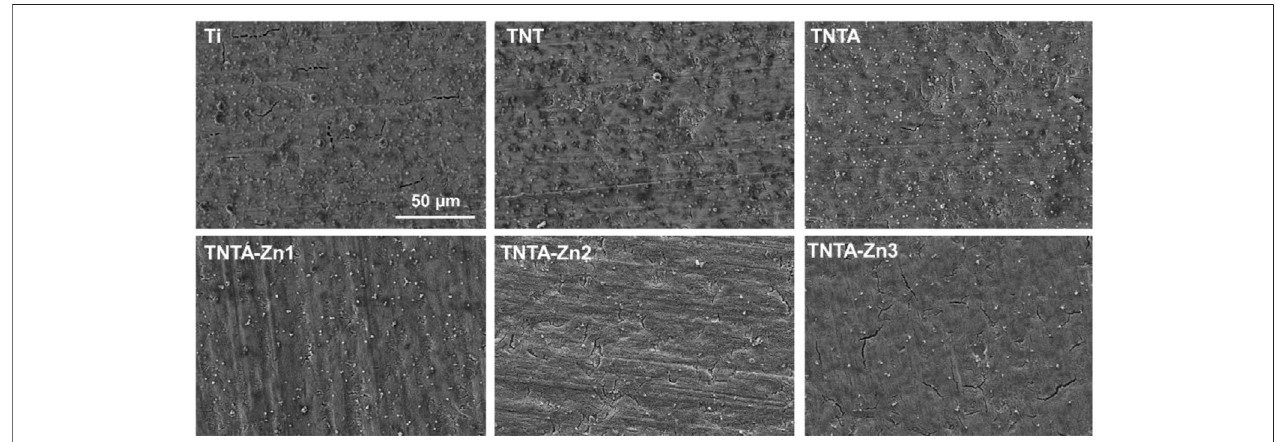
FIGURE 5 | SEM images of the attached platelets on the different